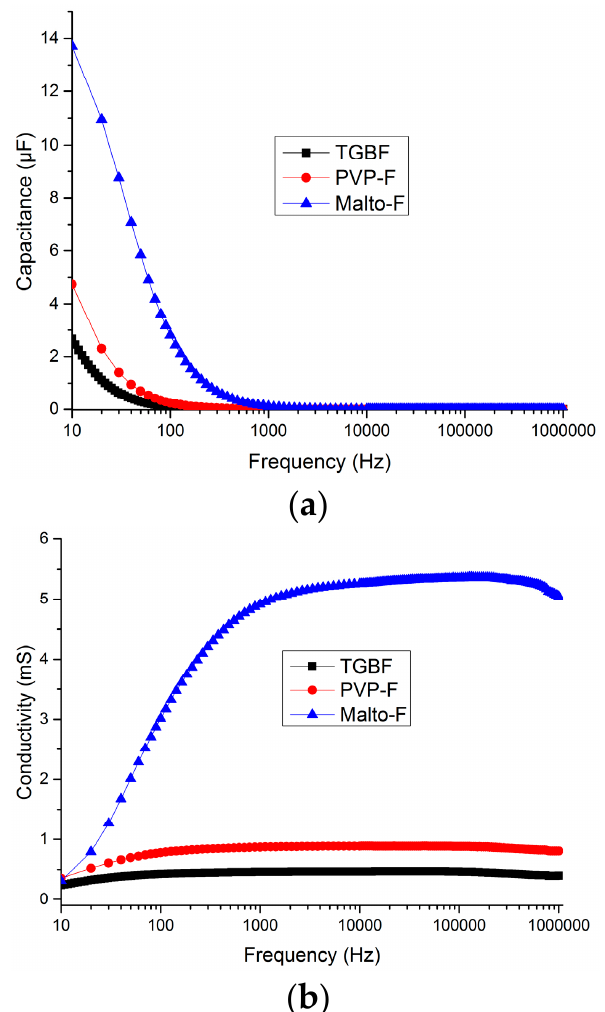
Figure 6. Frequency dependent conductivity spectra and frequency dependent capacitance spectra of compounds TGBF, PVP-F and Malto-F. ( a ) Capacitance; ( b ) Conductivity.